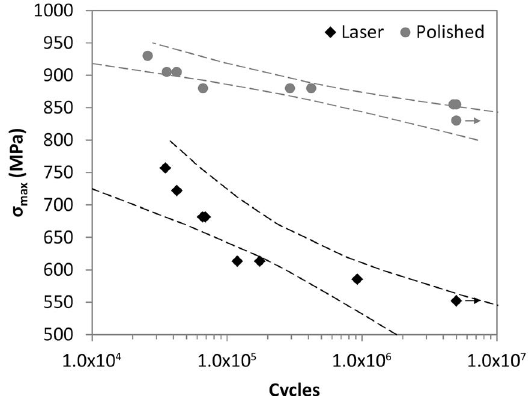
Figure 4. S-N curves for the polished and the surface modified by the laser treatment.